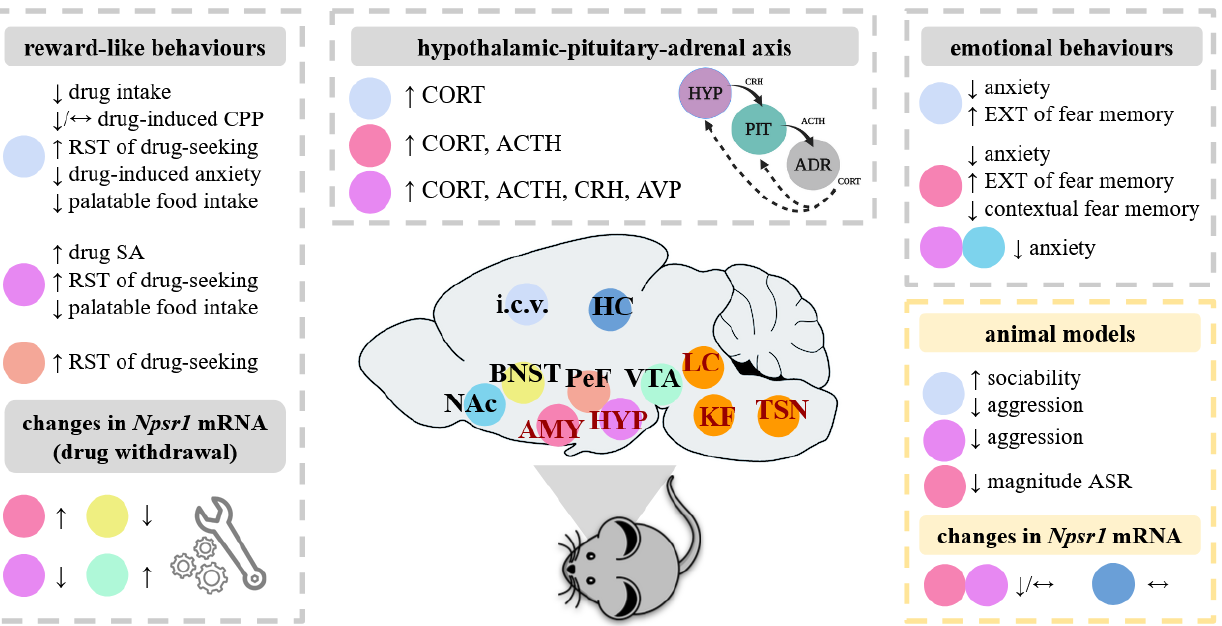
Figure 1. Overview of the impact of the administration of NPS in various brain areas in rodents. As depicted on this rodent brain (in dark red), the Nps precursor mRNA is expressed discretely in a few brain areas, including the trigeminal sensory nucleus (TSN), the locus coeruleus area (LC), the Kölliker – Füse nucleus of the lateral parabrachial area (KF), the hypothalamus (HYP) and the amygdala (AMY). By contrast to the Nps precursor mRNA, the Npsr1 mRNA is widely expressed in the rodent brain, here shown in the AMY, the bed nucleus of stria terminalis (BNST), the hippocampus (HC), the HYP, the perifornical area (PeF), the nucleus accumbens (NAc) and the ventral tegmental area (VTA). Rodent models allow experimental investigation into the role of the NPS/NPSR1 system in addiction-like and emotional behaviours, as well as neuroendocrine and behavioural stress responsiveness. In the papers analysed in the present review (see summary in Tables 1 and 3), NPS was administered in various brain areas and the effects of NPS were observed at the behavioural, endocrine and molecular level in naïve animals. Similar effects of NPS were generally shown in rodents exposed to stress or with innate pathological phenotypes (here referred to as “animal models”) , but other behaviours were affected and highlighted here. Abbreviations: ACTH, adrenocorticotropic hormone; ADR, adrenal; ASR, acoustic startle response; AVP, arginine vasopressin; CPP, conditioned place preference; CORT, corticosterone; CRH, corticotropin-releasing hormone; EXT, extinction; i.c.v., intracerebroventricular; NPSR1, neuropeptide S receptor 1; PIT, pituitary; SA; self-administration; RST, reinstatement. Symbols: ↑ , increase; ↓ , decrease; ↔ , no significant